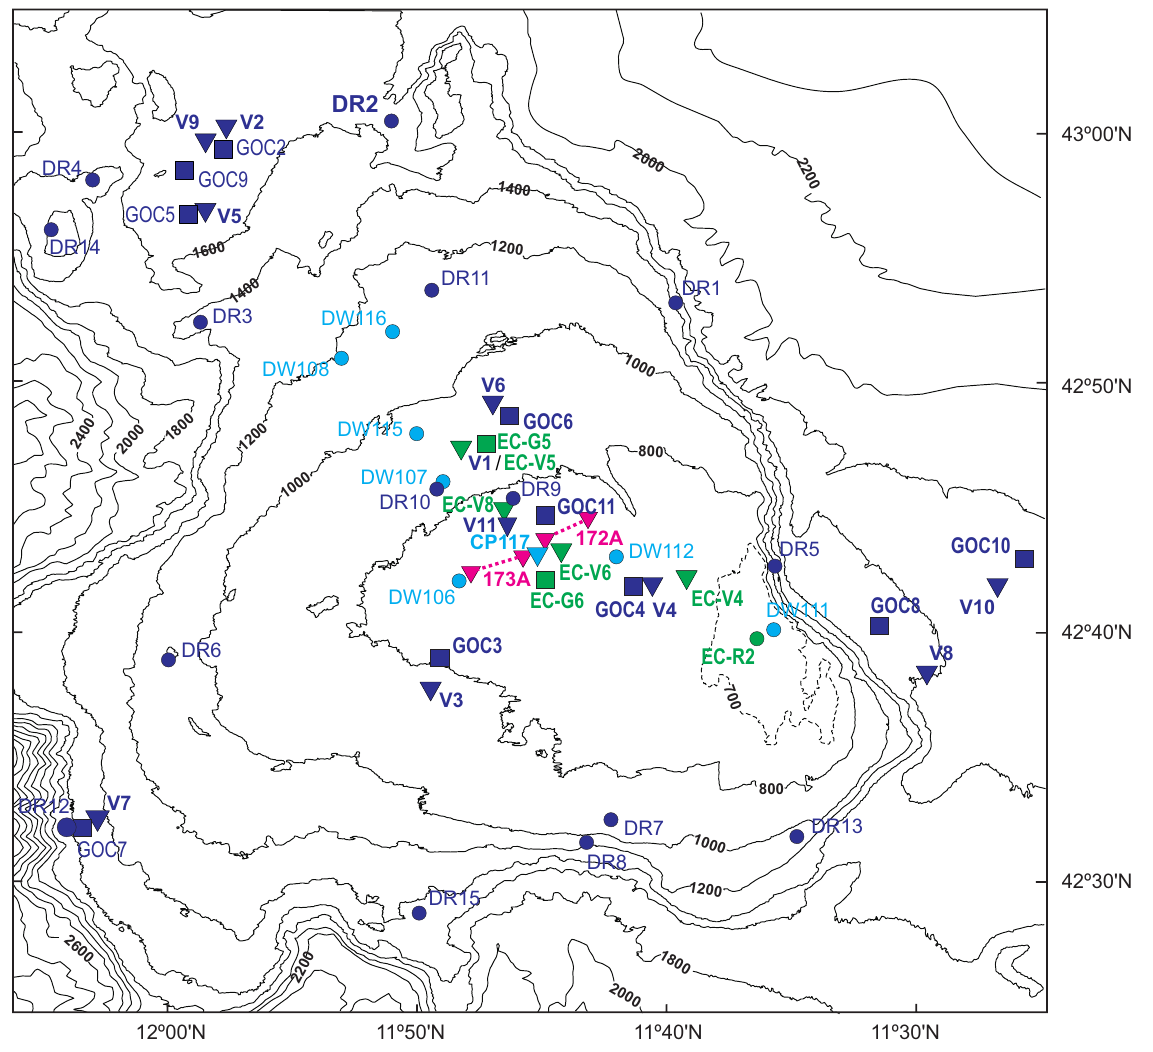
Fig. 2. Location of benthic samples used in this paper: SEAMOUNT 1 (turquoise), FAUNA II (red), ECOMARG 0709 (green) and INDEMARES BANGAL 0711 (deep blue). Symbols for sampling gears: rock dredge (circles; DW, R or DR), beam trawl (triangles; A, V or CP), otter trawl (squares; G or GOC). Isobaths every 200 m except for shallowest at 700 m; isobaths on the bank proper down to 2000 m from multibeam bathymetry (EEZ Project), completed with GEBCO regional bathymetry for the